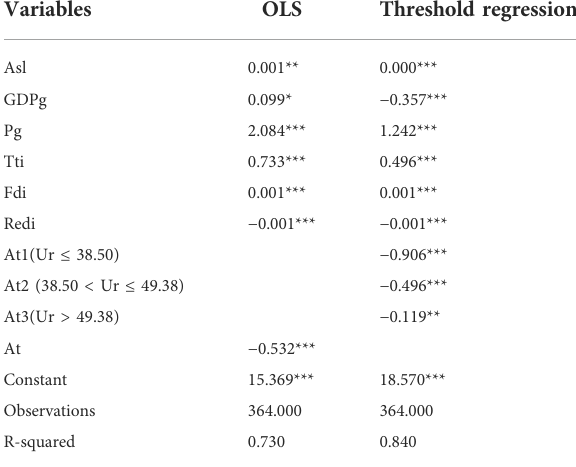
TABLE 11 Panel regression